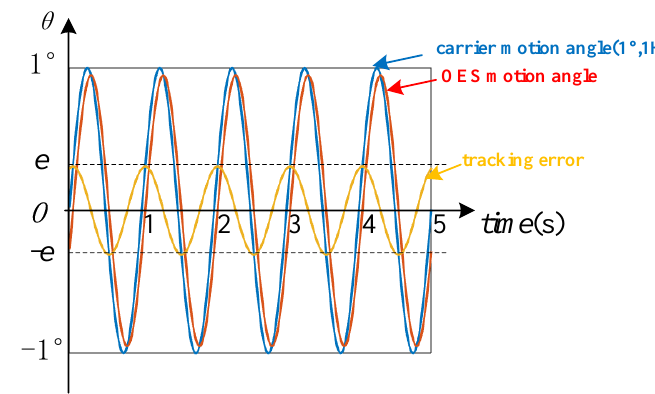
Figure 7. The method for obtaining the inertial stability accuracy of the OES.